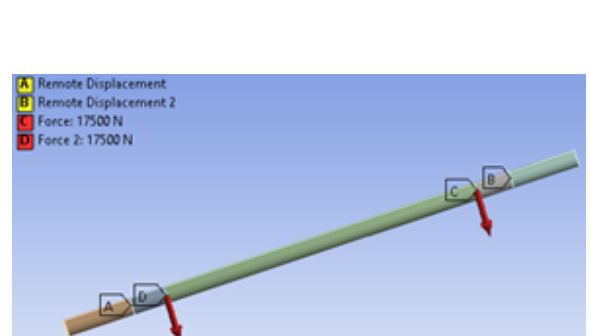
Fig. 7. Round bar support boundary